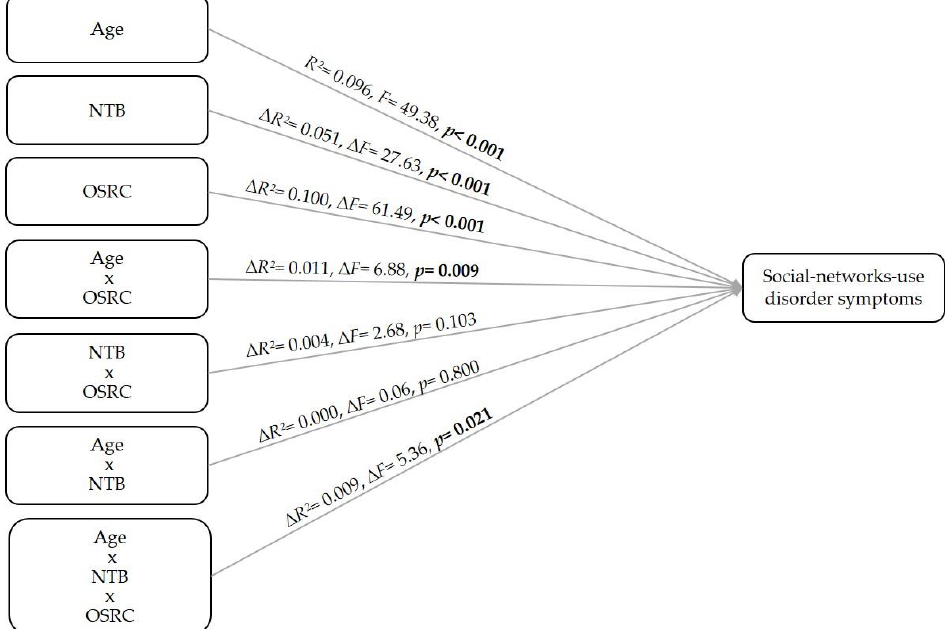
Figure 2. Results of the hierarchical moderated regression analysis with symptoms of a social-networks-use disorder as dependent variable and age, need to belong (NTB), and online self-regulative competences (OSRC) as well as their respective interactions as